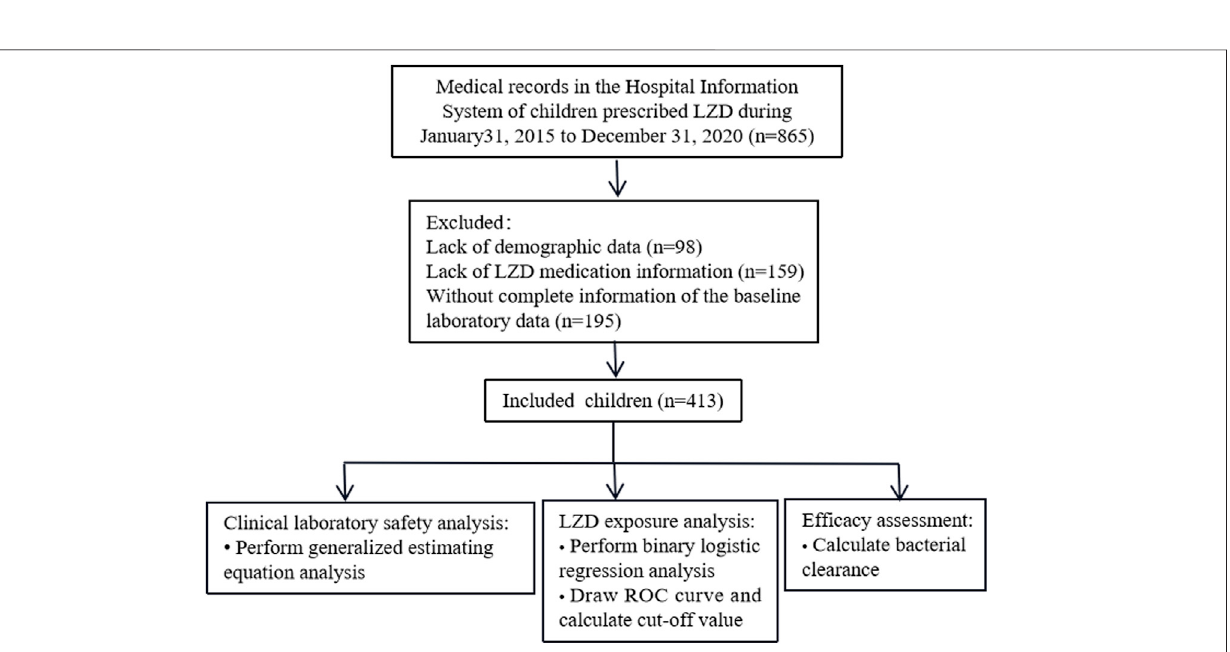
FIGURE 1 | Flow chart for patient